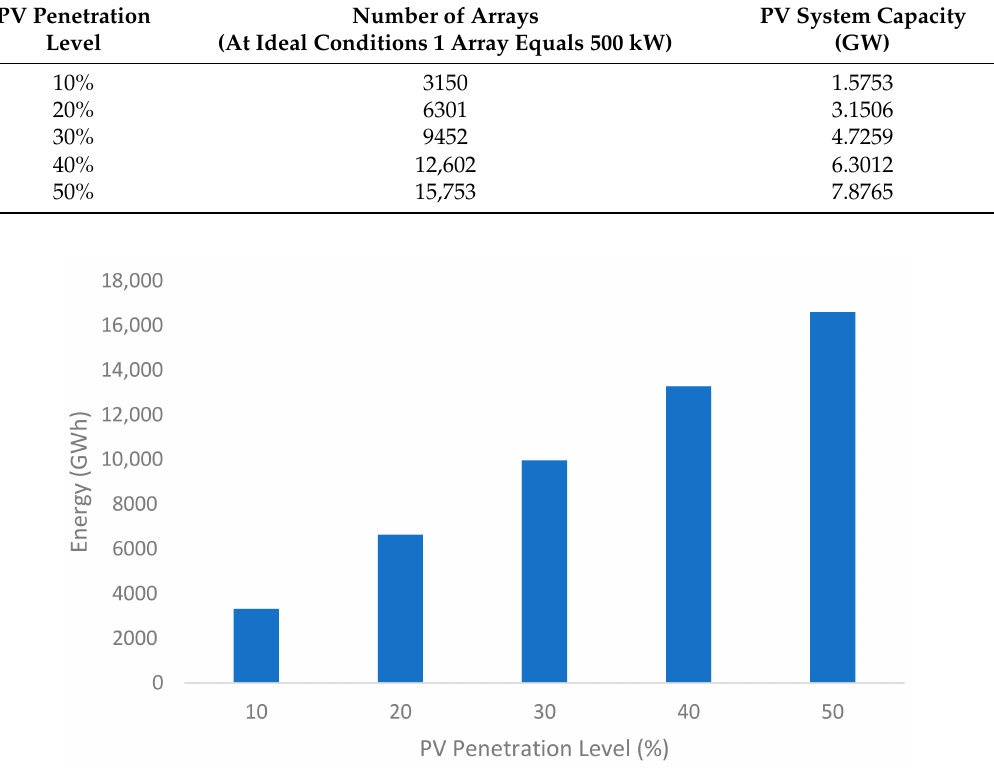
Figure 9. The total PV system’s output at various penetration levels for the Riyadh, 2017,